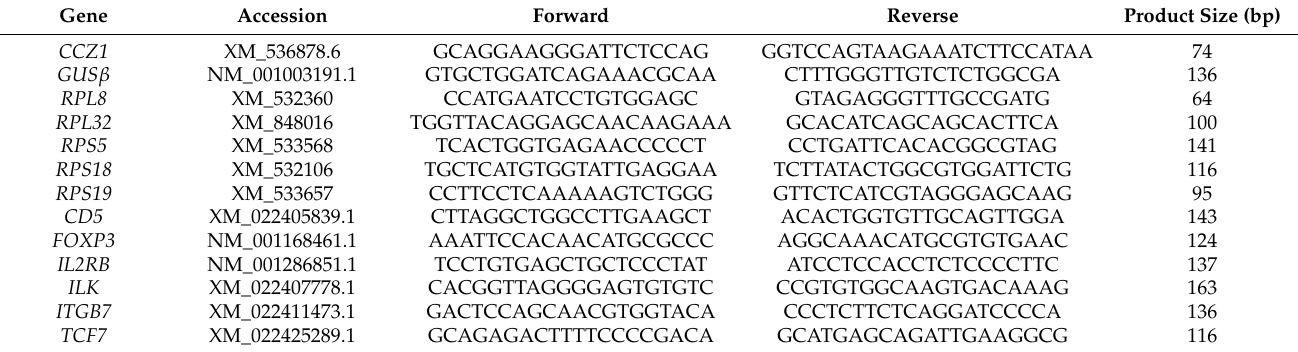
Table 1. Primer sequences for quantitative real-time